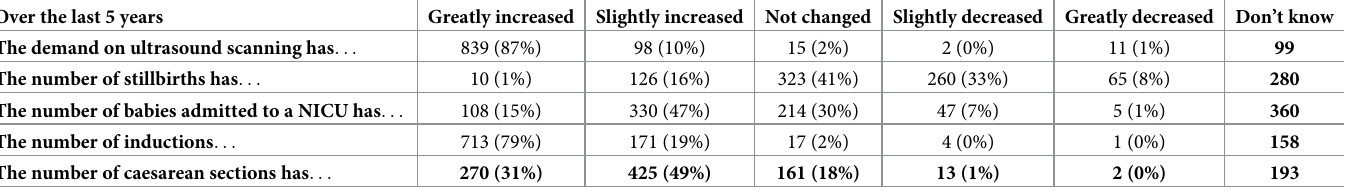
Table 4. Staff views about changes in practice and outcomes in their Trust over the time frame of adoption of the SBL care bundle (n = 1,064). Over the last 5 years Greatly increased Slightly increased Not changed Slightly decreased Greatly decreased Don’t know The demand on ultrasound scanning has ... The number of stillbirths has ... The number of babies admitted to a NICU has ... The number of inductions ... The number of caesarean sections has ... Percentages calculated as proportion of those who expressed a view regarding the